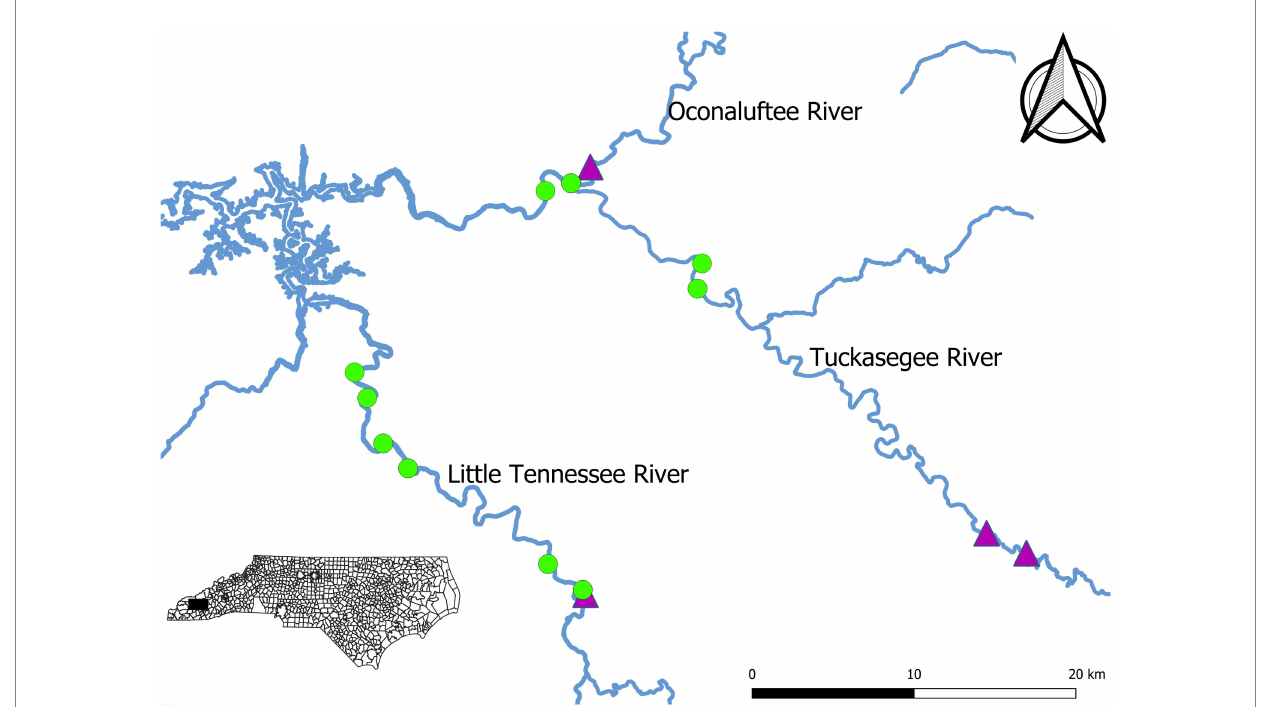
FIGURE 1 Map of Sicklefin Redhorse Moxostoma sp. electrofishing sampling sites (green points) on the Little Tennessee River and Tuckasegee River in western North Carolina. Dams are indicated by purple